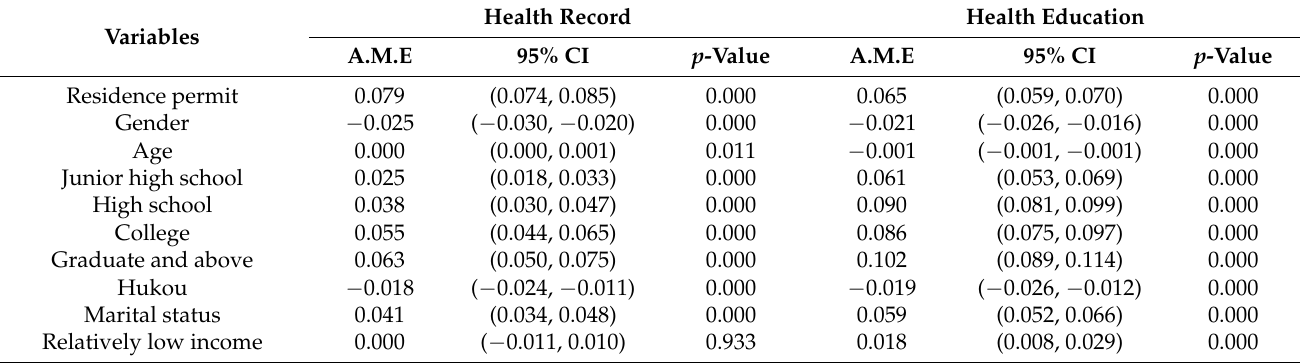
Table 2. Average marginal effects of residence permit on the utilization of public health services.